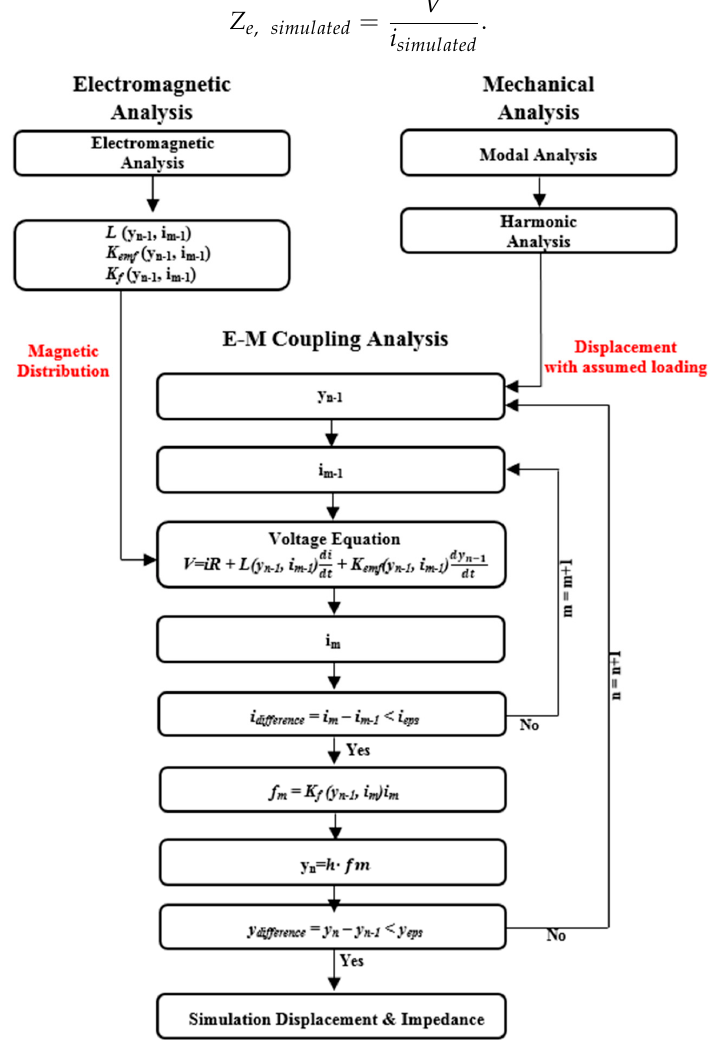
Figure 7. Flowchart of analysis procedures.